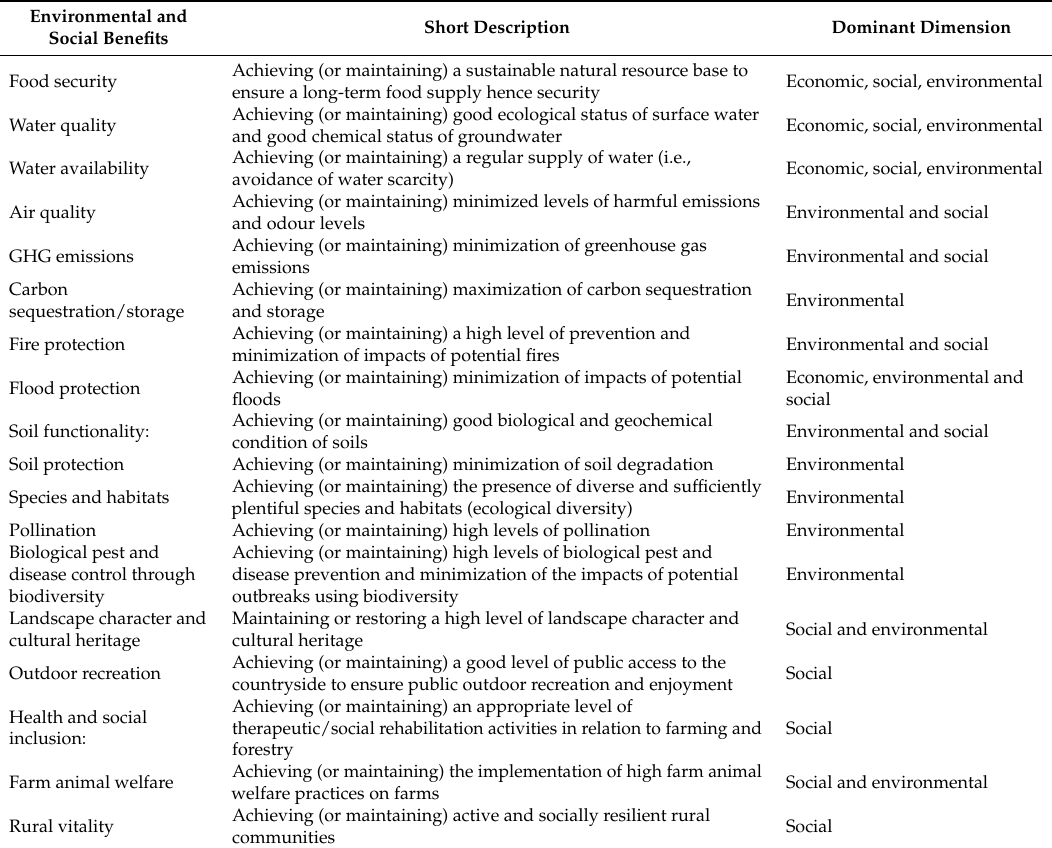
Table A1. List of environmental and social